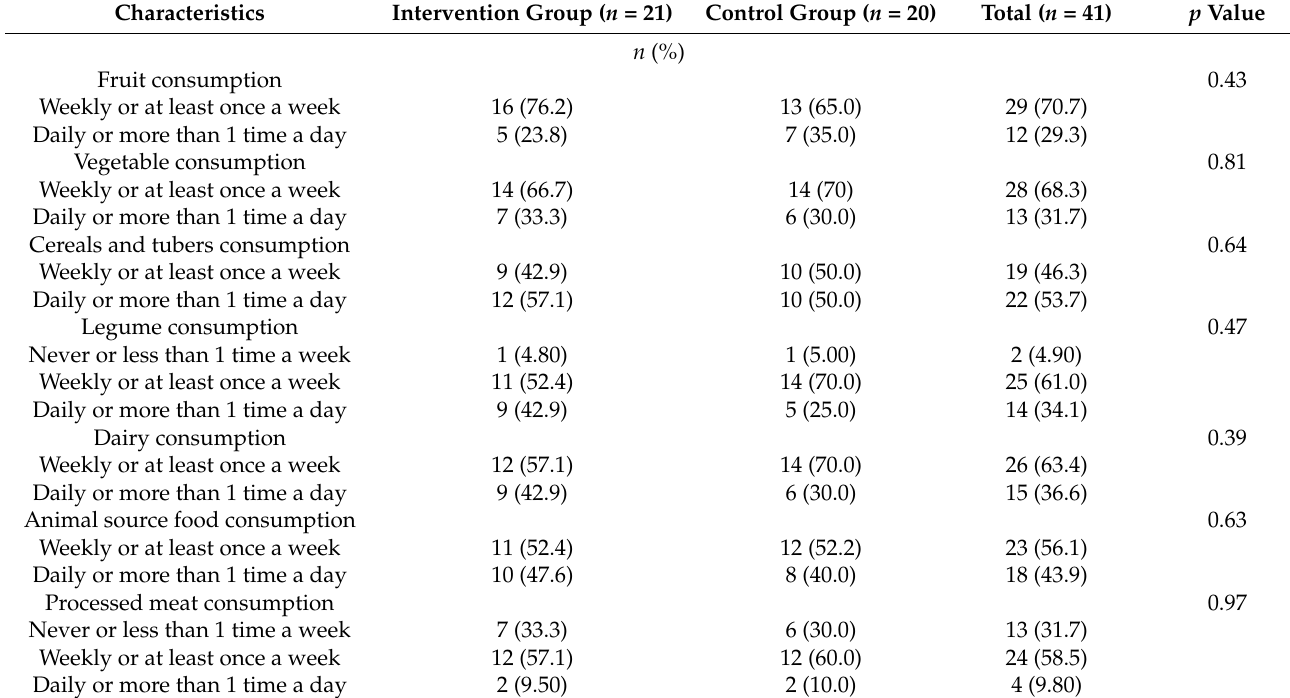
Table A1. Baseline food consumption of the intervention group (Planet Nutrition program) and control group